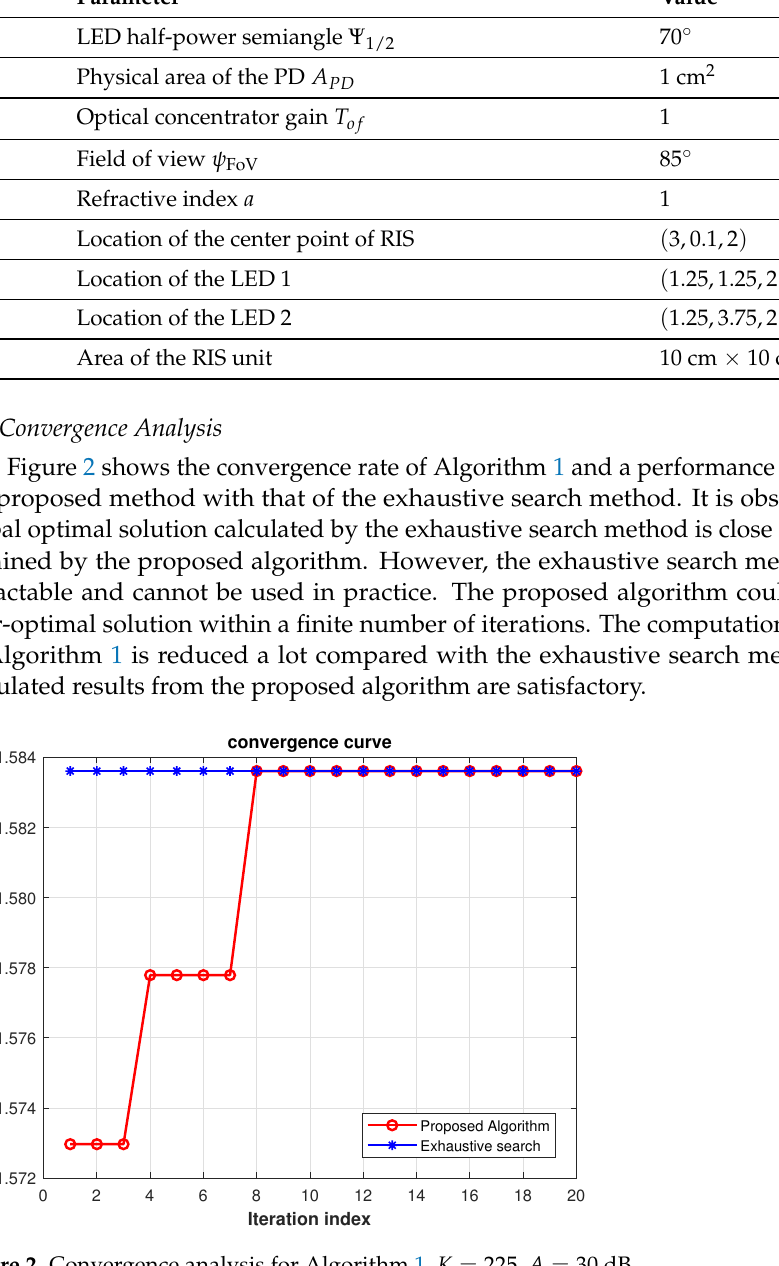
Figure 2. Convergence analysis for Algorithm 1, K = 225, A = 30